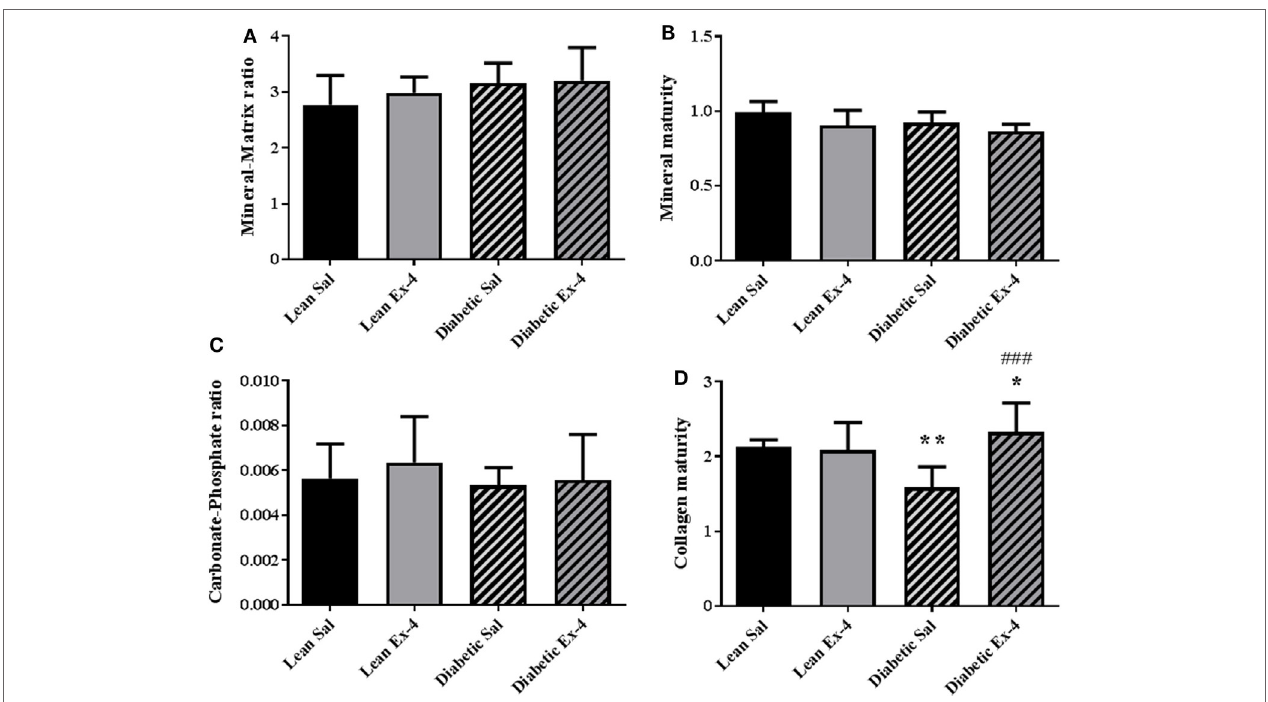
FigUre 7 | Effect of Exenatide on tissue material properties assessed at bone formation sites in db/db and control mice. Measurements were performed by Fourier-transform infrared microscopy between the fluorescent labels of the trabecular region of tibial sections in 13-week-old db/db and lean mice treated with either Exenatide or saline. (a) Mineral-to-matrix ratio. (B) Mineral maturity. (c) Carbonate-to-phosphate ratio. (D) Collagen maturity index. Bars represent mean ± SD of n = 10 mice/group, * P < 0.05, ** P < 0.01 versus lean Sal; ### P < 0.001 versus diabetic